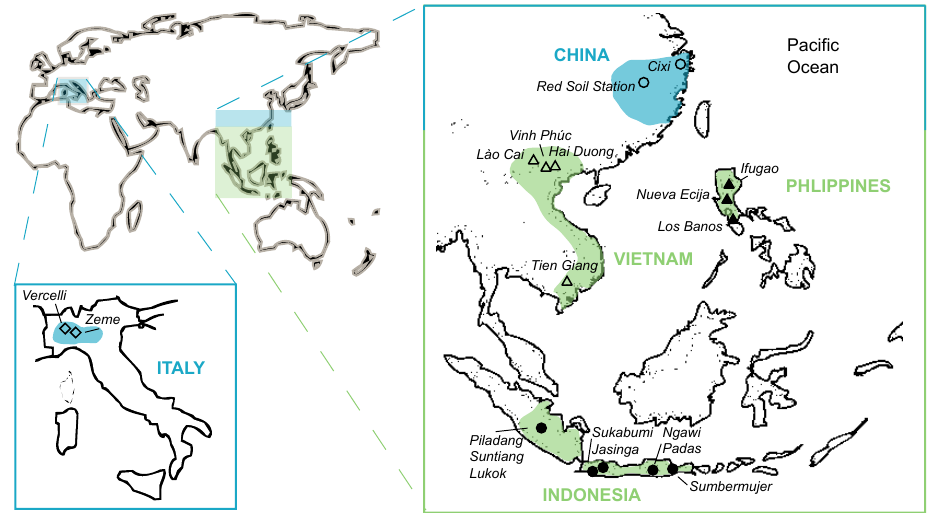
Figure 1. Map of sampling locations. Blue coloured area denotes subtropical sampling locations and green denotes tropical sampling loca-